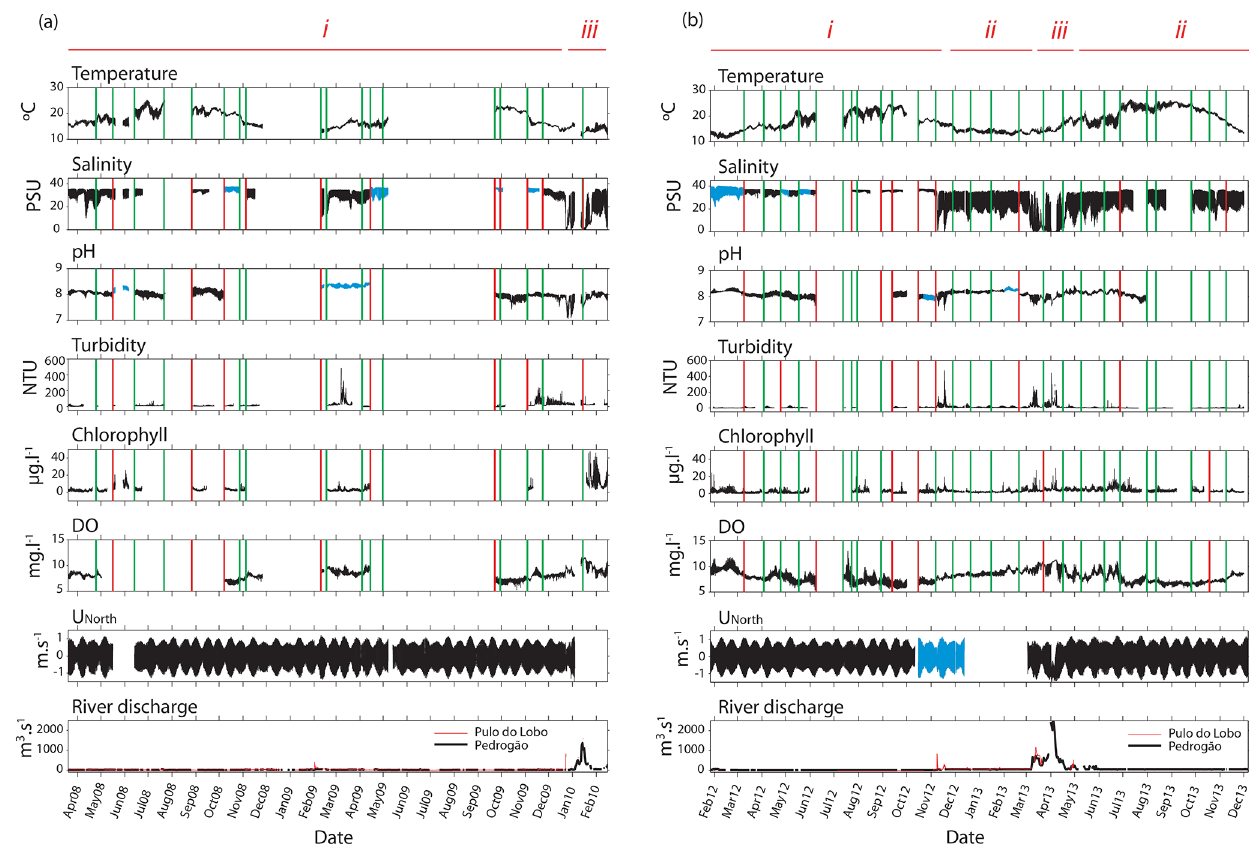
Figure 4. Time series of validated (black) probe data in (a) March 2008–February 2010; and (b) January 2012–December 2013. Ambiguous data are indicated in blue. The valid north component of the main-cell ADP velocities (Unorth) are also reported in black, with accepted values in blue. The time of probe cleaning and sensor calibration are indicated with the green and red vertical lines, respectively. The lower graph indicates the river discharge recorded at Pedrogão (thick black line) and Pulo do Lobo (red line) stations. The main discharge regimes are synthesised (in red) on top of panels (a) and (b) , with (i): zero river discharge, (ii) ecological flow (river discharge ∼ 50m 3 s − 1 ), and (iii) high river discharge (>1000m 3 s − 1